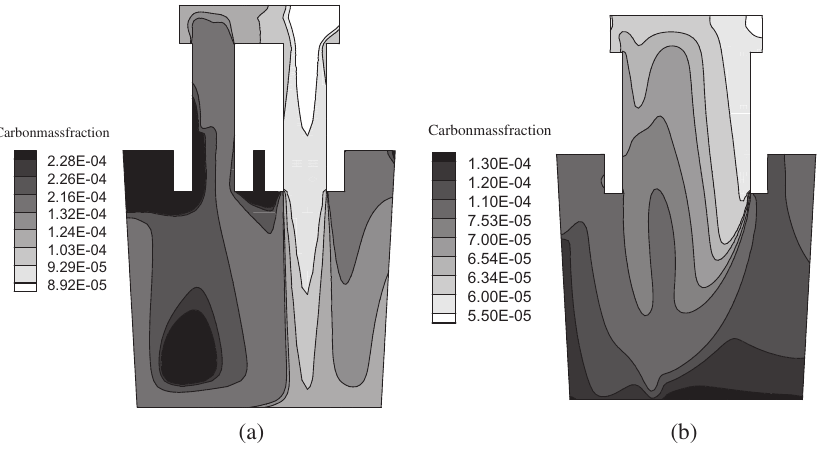
Figure 5: Distribution of carbon mass concentration at the main plane after 240 sec. (a) RH (b) SSF.